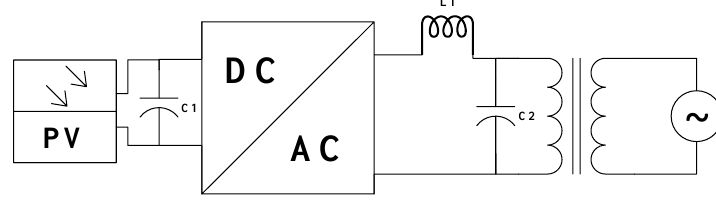
Figure 2. PV system with a line-frequency transformer